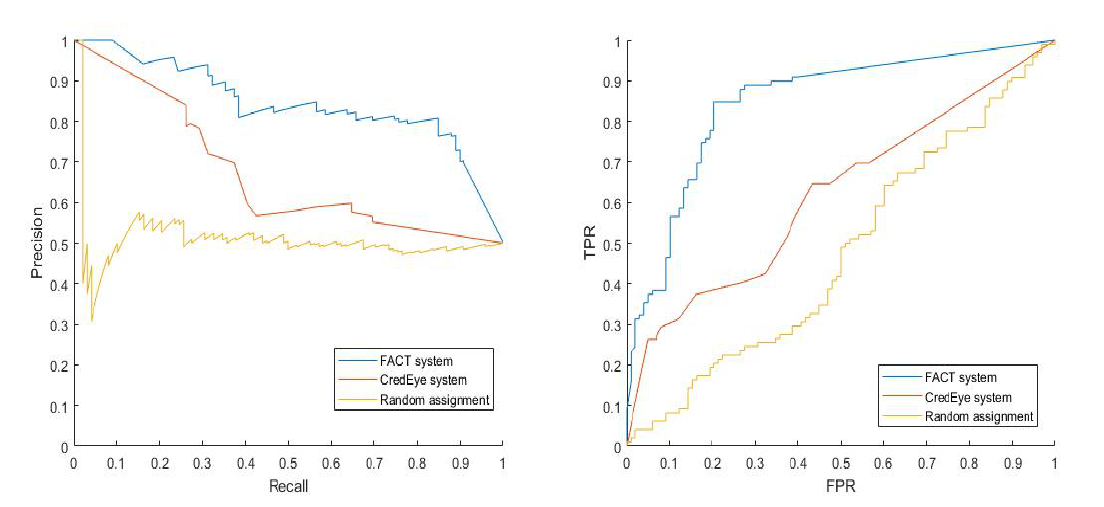
Figure 5. Performance figures. In the graph, the blue line represents system FACT, the red line represents CredEye system, and the yellow line represents the random